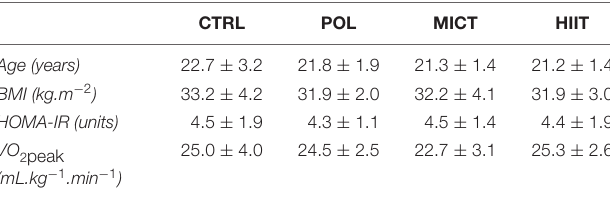
TABLE 1 | Basal characteristics before 12-weeks of